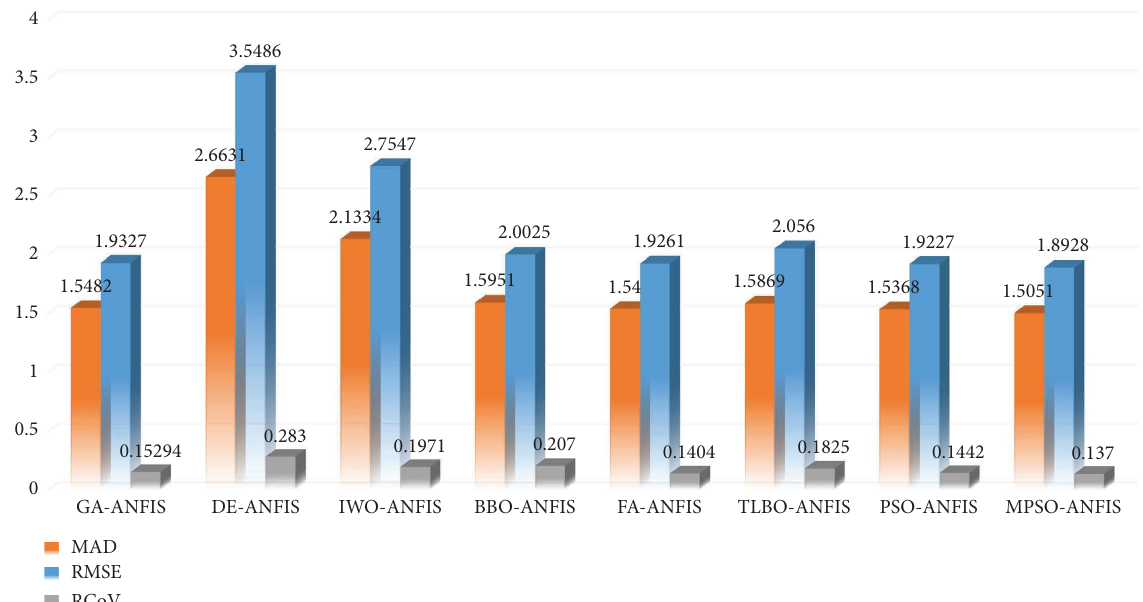
Figure 13: Comparison of diferent statistical indices for the hybrid